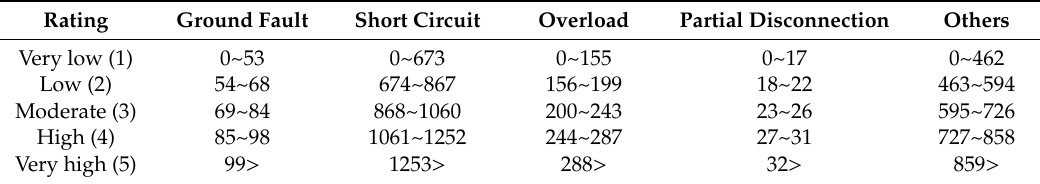
Table 5. The risk rating scale for electrical fires by cause.